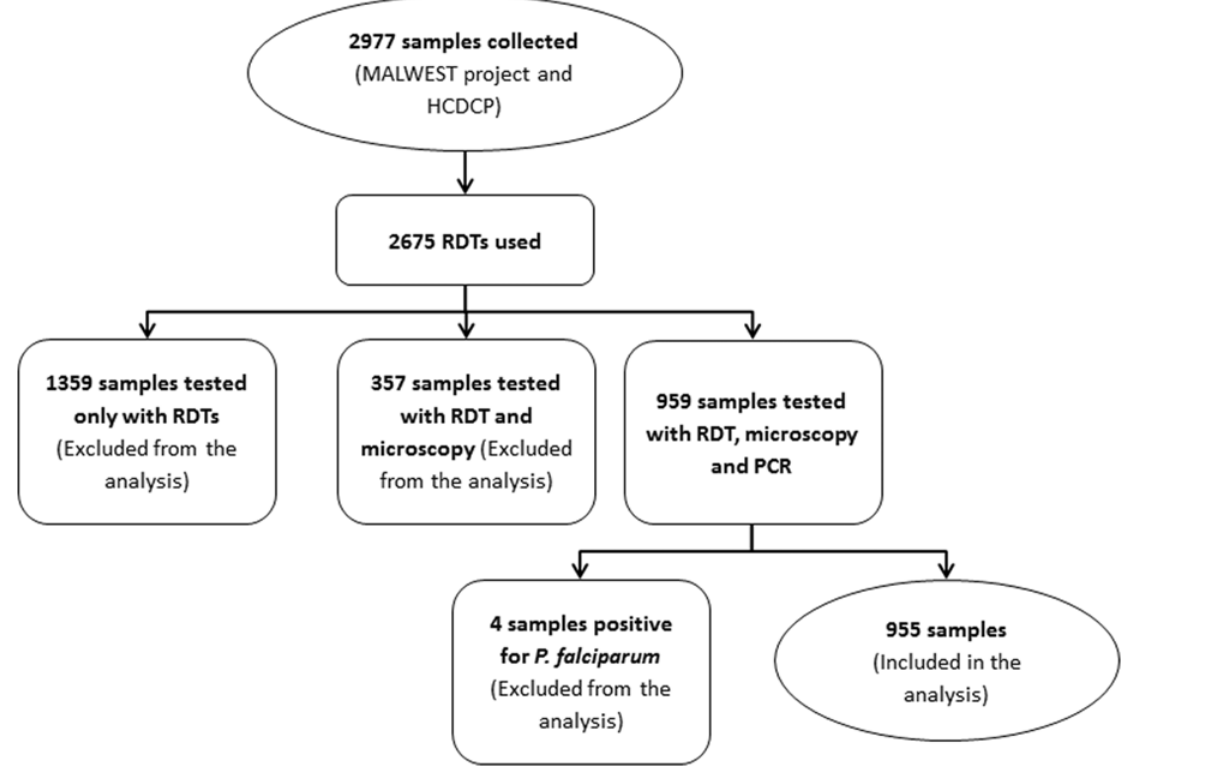
Fig 1. Flow chart of all samples collected for malaria in Greece